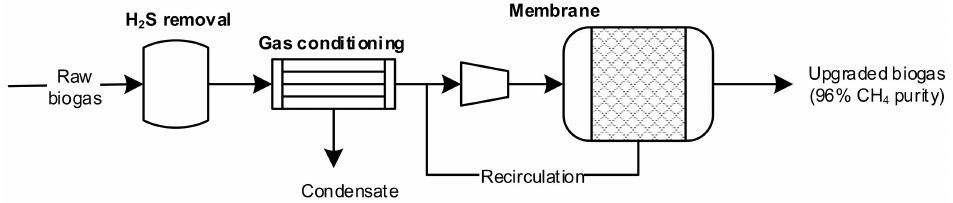
Figure 9. Scheme of membrane gas separation process. Adapted from Muñoz et al.